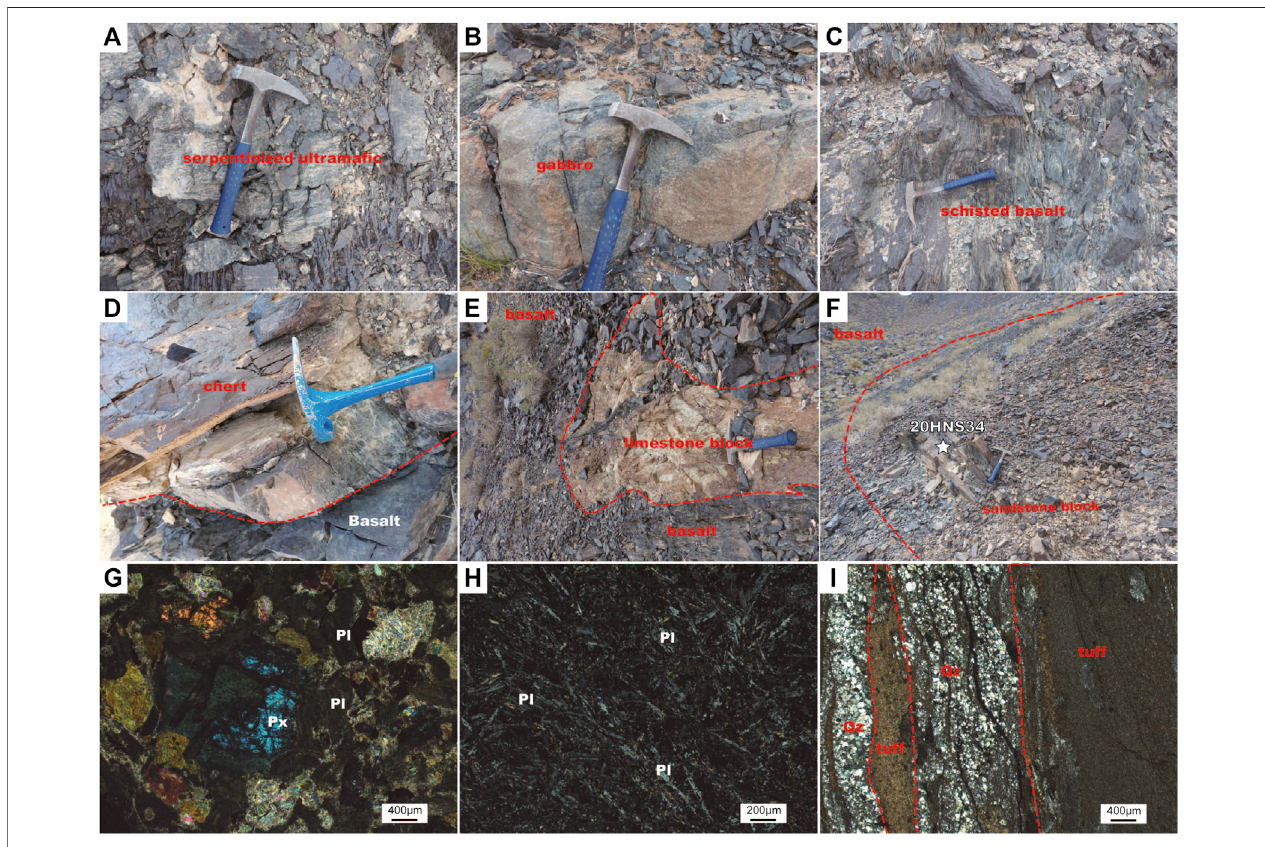
FIGURE 4 | Field photos and microphotos for different rocks of the Huaniushan complex, Beishan. (A) Serpentinized ultrama fi c; (B) gabbro; (C) schist basalt; (D) chert and basalt; (E) limestone blocks in basalt; and (F) sandstone. (G – I) Microphotos of gabbro, basalt, and sandstone. Px, pyroxene; Pl, plagioclase; Qz, quartz.